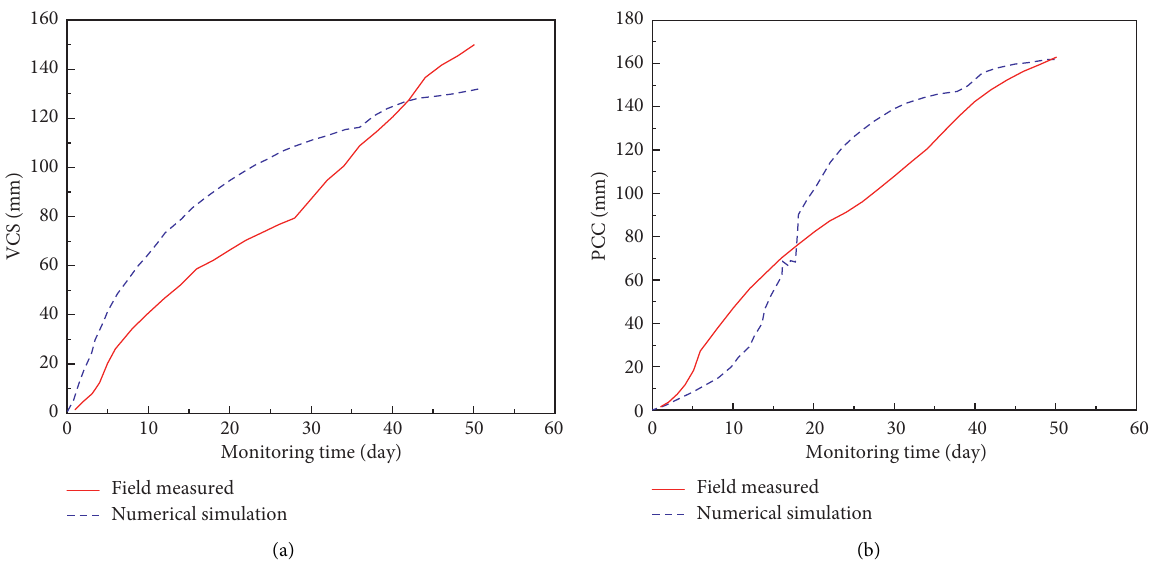
Figure 11: Comparison of numerical simulation results with in-site monitoring. (a) The VCS of the field measured and numerical simulation. (b) The PCC of the field measured and numerical